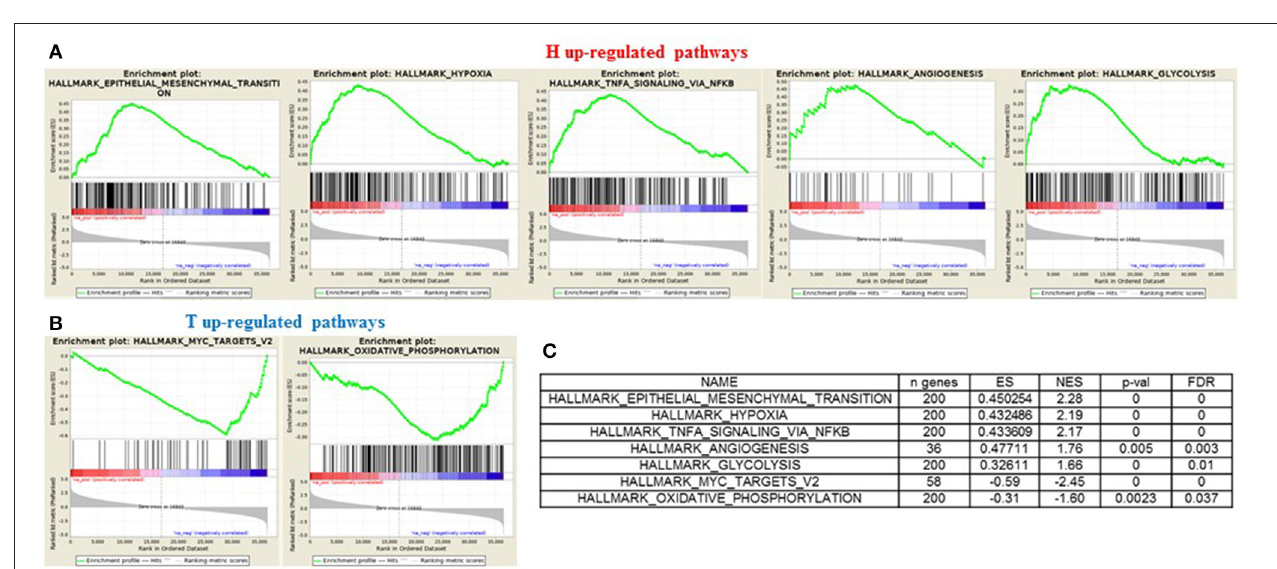
FIGURE 6 | GSEA “H phenotype” vs. “T phenotype.” Enrichment score plot of EMT, Hypoxia, Angiogenesis, NFKB, Glycolysis terms (A) and myc_targets_v2, oxidative_phosphorylation terms (B) positive enriched in hematogenous or transcelomic patients group. The plots contain the profile of the running enrichment score (ES-green line) and positions of gene set members on the rank ordered list in GSEA (black strokes on the bottom). (C) GSEA result summary.